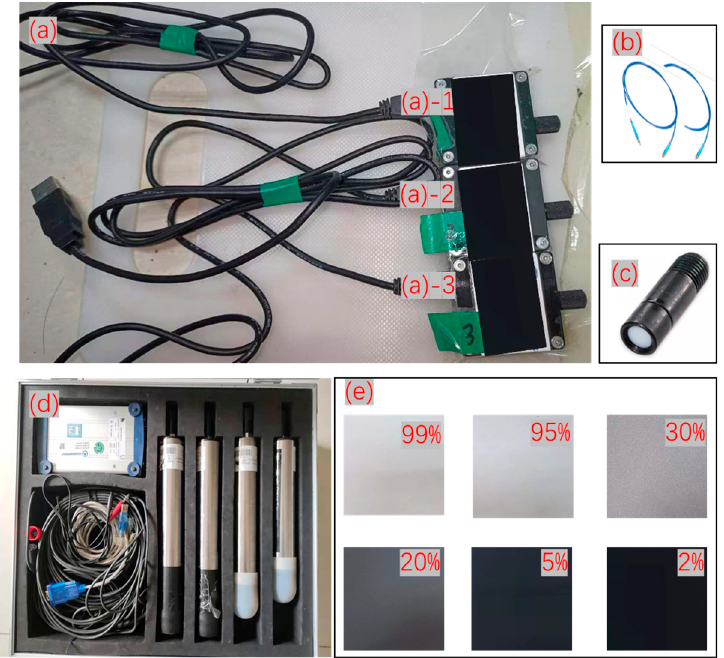
Figure 1. ( a ) Ocean Optics micro-spectrometers (STS-VIS); (a)-1 sensor for measuring sky radiance; (a)-2 sensor for measuring water radiance; (a)-3 sensor for measuring downward irradiance. ( b ) Ocean Optics and Hygirel fiber. ( c ) Cosine Correctors. ( d ) Trios. ( e ) Diffuse reflectance plates and target cloth (99%, 95%, 30%, 20%, 5%, and 2%). Table 1. Parameter table of Trios and STS-VIS. Trios STS-VIS Wavelength (nm) 200–1100 350–810 Optical Resolution (nm) 3.3